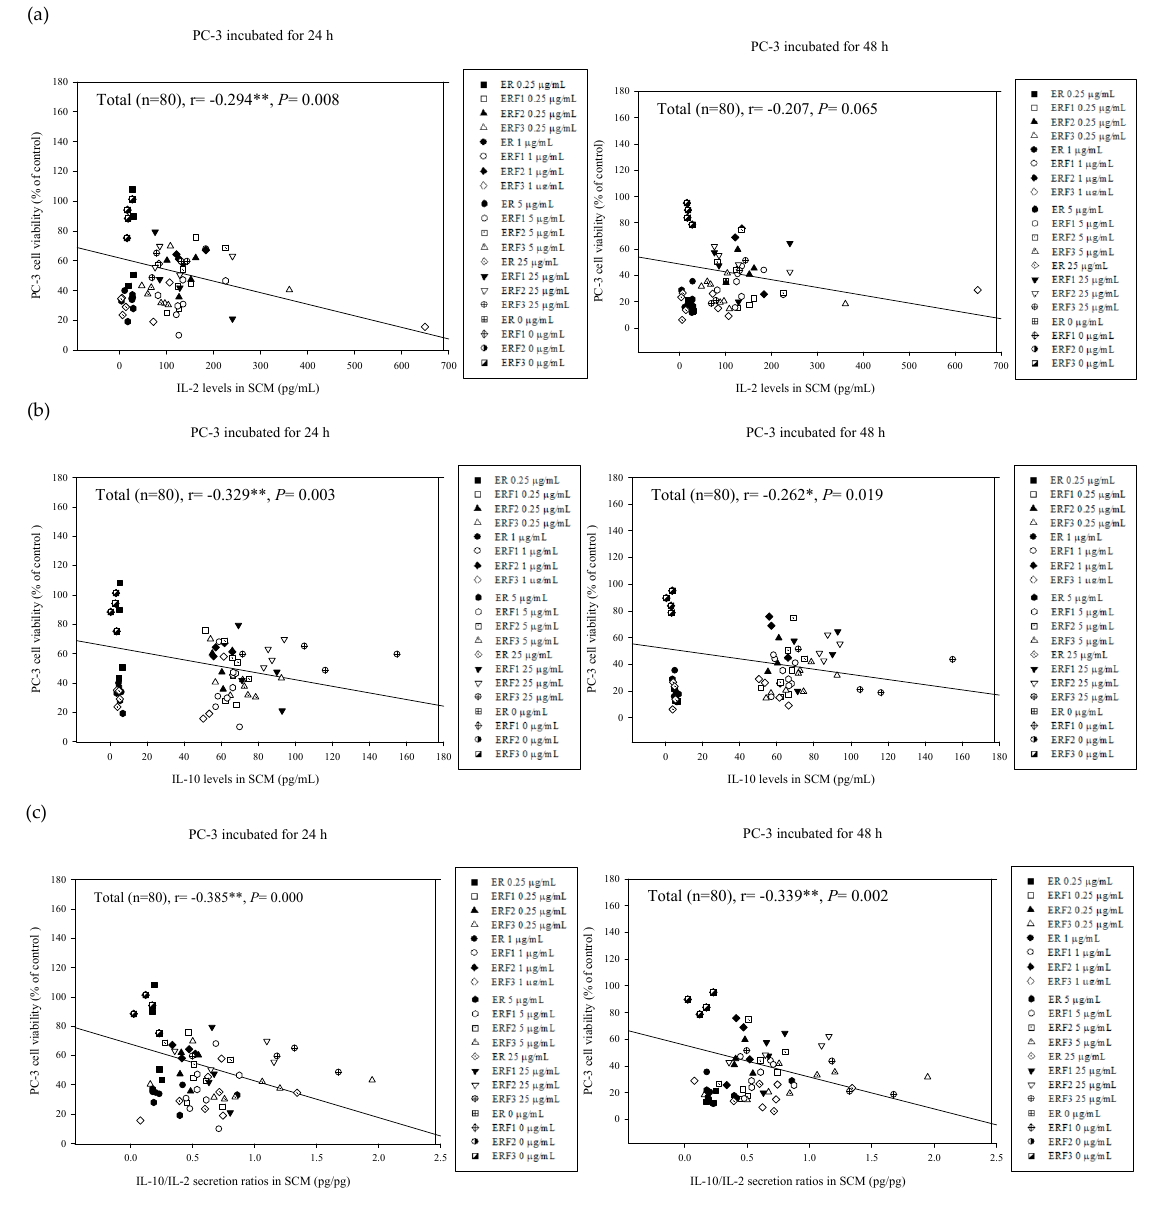
Figure 8. The associations between IL-2 ( a ), IL-10 ( b ), as well as IL-10/IL-2 cytokine secretion ratios ( c ) in SCM and their corresponding PC-3 cell viabilities treated with SCM for 24 and 48 h, respectively. The correlation was expressed by Pearson product–moment correlation coefficient (r). * p < 0.05; ** p < 0.01. 3.8. Associations between PC-3 Cell Viability Treated with Direct Action and Total Polyphenol and Flavonoid Contents in ER SDEO and Its Isolated Fractions ERF1–F3 Correlations between total polyphenol and flavonoid contents in the media with ER SDEO as well as its isolated fractions ERF1–F3 and PC-3 cell viabilities were determined using the Pearson product–moment correlation coefficient (r) (Figure 9). The results showed that total polyphenol and flavonoid contents in the media were slightly, but not significantly (p > 0.05), negatively correlated with PC-3 cell viability through either 24-h or 48-h incubation, reflecting that total polyphenol and flavonoid in SDEO purified frac- tions might play a minor role in the inhibition to PC-3 cell viability with direct action (Figure 9). In comparison with these associations, it can be concluded that phenolics and flavonoids may effectively modulate the immune balance and subsequently inhibit PC-3 cell growth, rather than directly inhibiting PC-3 cell growth. PC-3 incubated for 24 h Total polyphenol levels in the media using ER SDEO fractions (ng/ml) 0